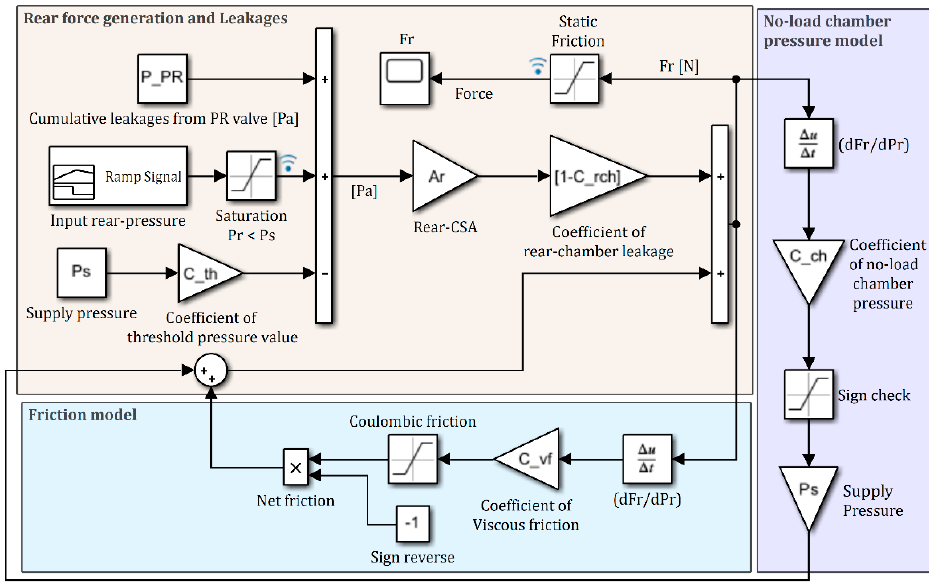
Figure 13. Simulink block diagram of the nonlinear static force model of the actuator with pressurized flow supplied to the rear chamber.